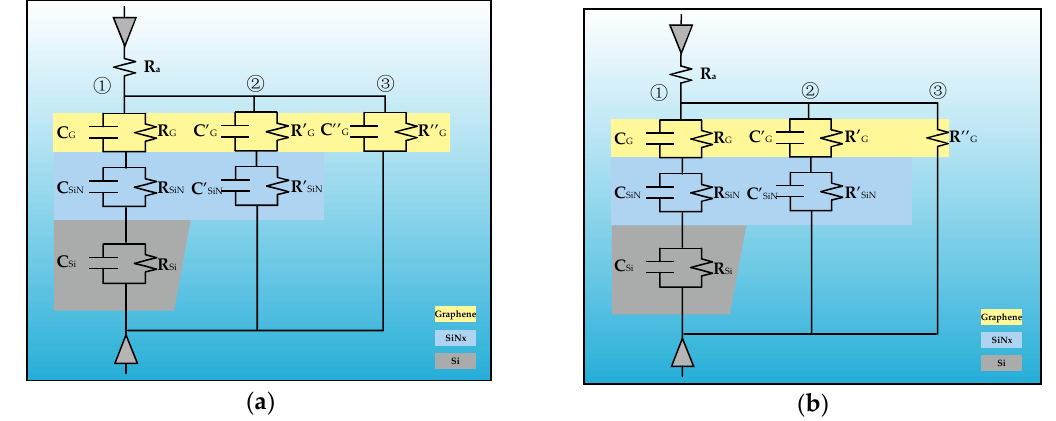
Figure 7. Equivalent circuit of monolayer graphene nanopore regime: ( a ) equivalent circuit of the extensive suspended model; and ( b ) the equivalent circuit of the narrow free-standing model.